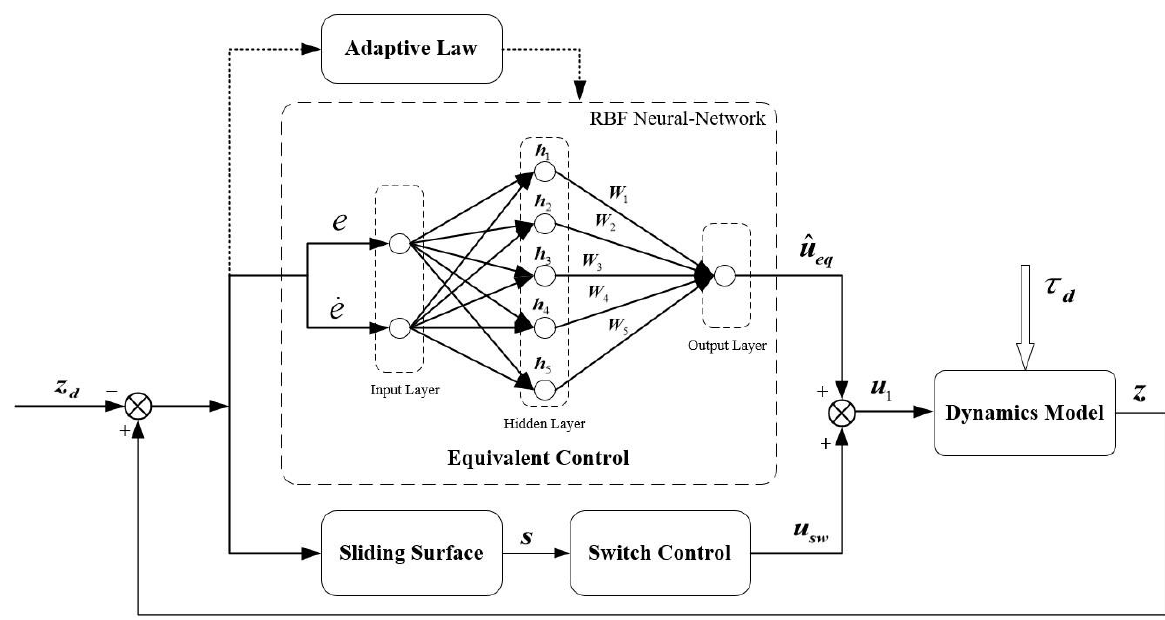
Figure 5. The structure of the NGFTSMC for altitude control, based on the RBFNN observer.